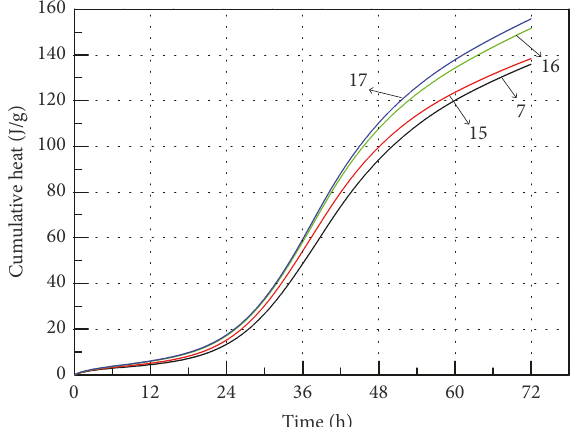
Figure 19: Cumulative heat versus time of references with SCA-